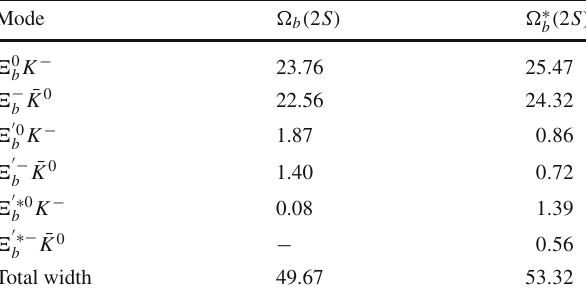
Fig. 5 The dependence of the decay width on the harmonic oscillator 1 parameter α ρ for the J P = 5 / 2 − state Table 3 Decay widths of the (cid:2) b ( 2 S ) states in